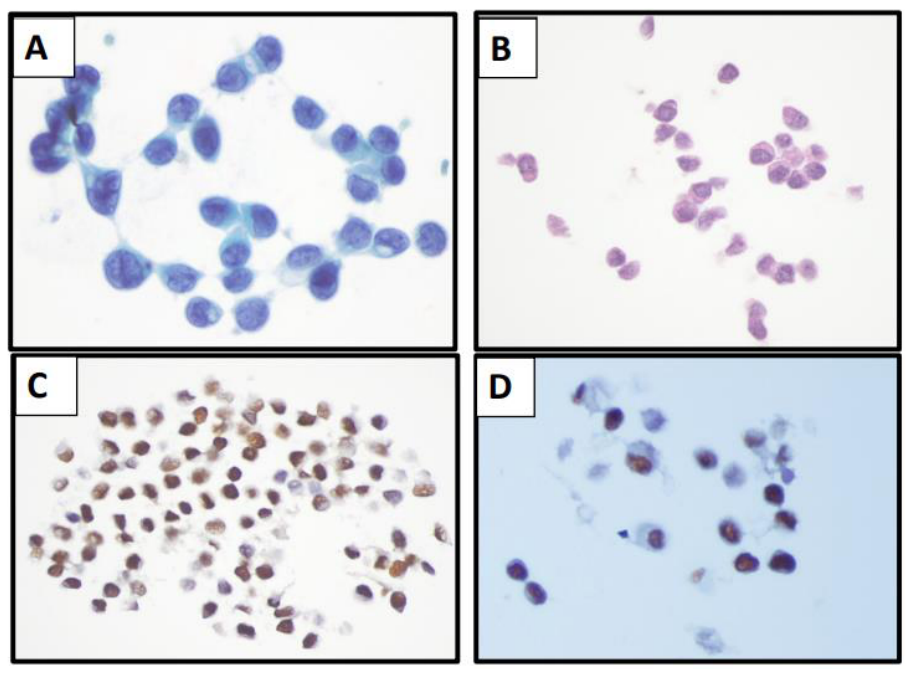
Figure 2. ( A – D ) Lobular carcinoma of breast metastatic to thyroid. ( A ) Dyscohesive single cell pattern of moderately pleomorphic tumor cells with intracytoplasmic lumina (Pap Stain). ( B ) Cell block is concordant and highlights single cell pattern (H&E stain). ( C ) Immunohistochemical stain for ER shows strong positive staining in the majority of tumor cells. ( D ) GATA-3 shows positive staining in tumor cells consistent with breast primary (Images contributed by John P. Crapanzano, MD, Columbia University Medical Center).